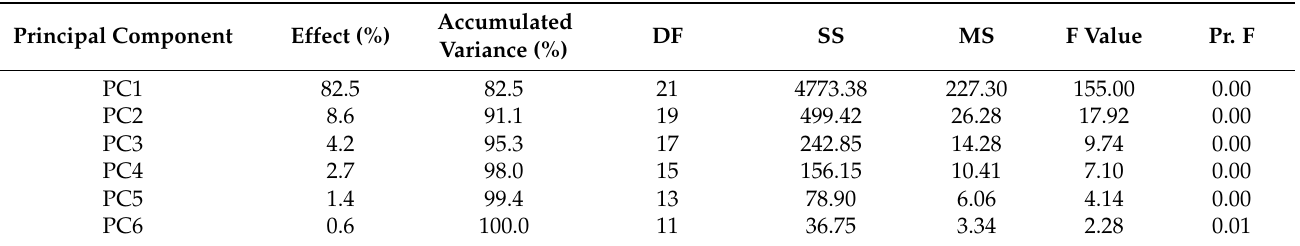
Table 4. Analysis of variance of principal components of biplot genotype and environment of the Boro elite rice genotypes in six